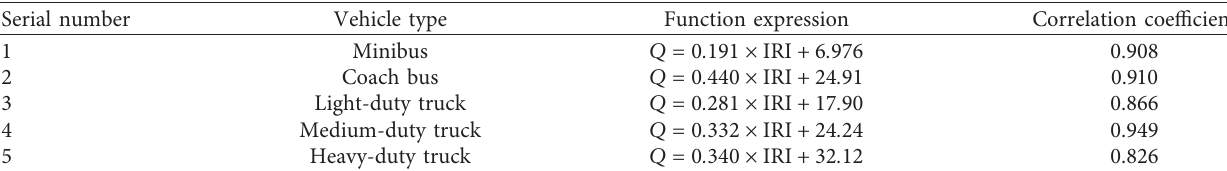
Table 5: Roughness-fuel consumption model at the baseline